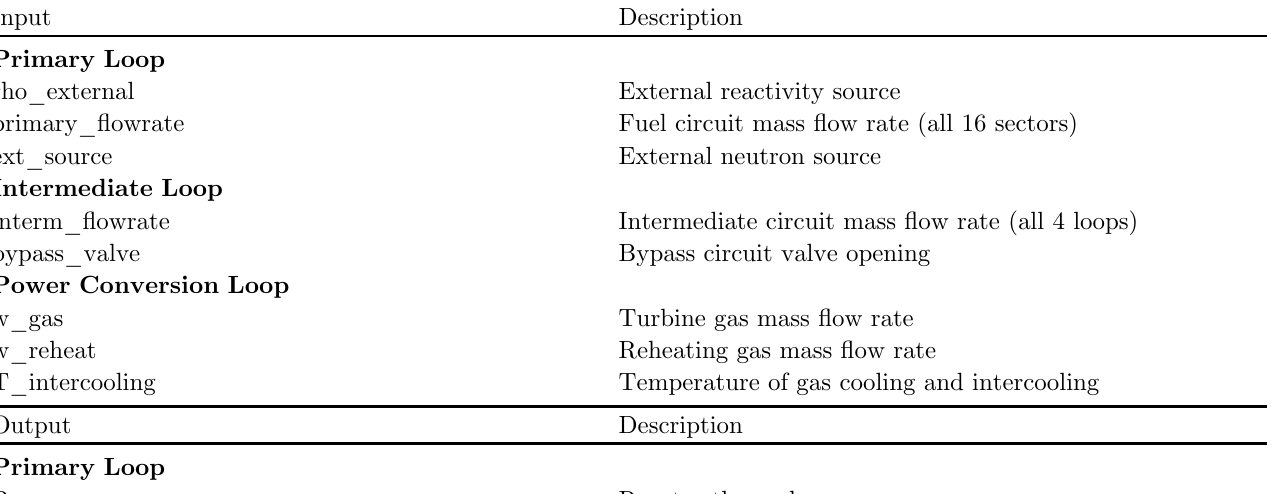
Table 5. Description of the simulator input and output